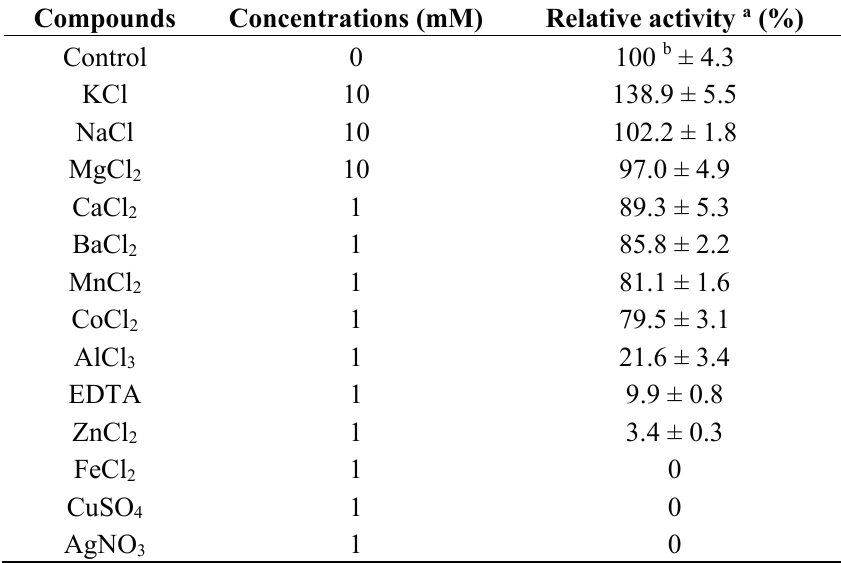
Table 2. Effect of metal ions and EDTA on the activity of